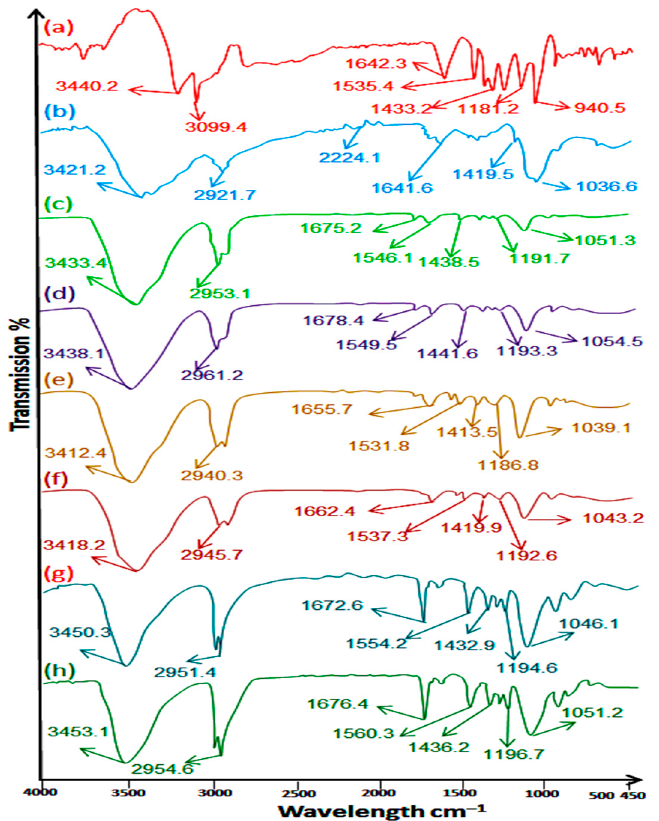
Figure 1. ATR FTIR spectra of (a) methotrexate, (b) chitosan, (c) FNE1, (d) FNE2, (e) FNE3, (f) FNE4, (g) FNE5, (h)